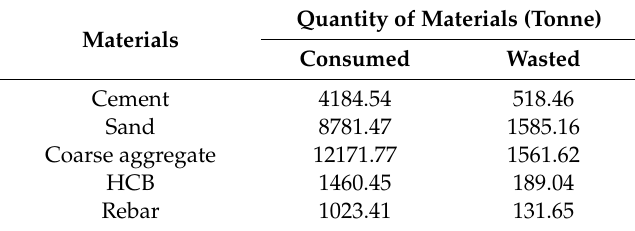
Table 3. The cumulative quantity of the top five consumed and wasted materials of the case